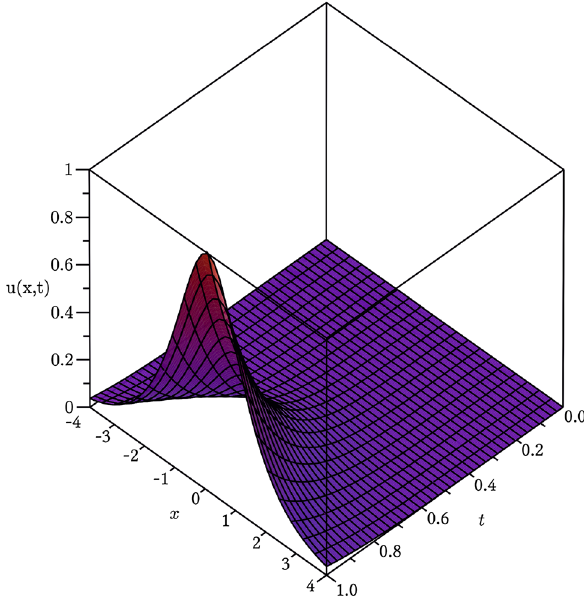
Fig. 1 Plot of approximate solution of Example 1 for α = 0 . 5, τ = 0 . 005 and [ a , b ] = [− 4 , 4 ] obtained by IQ-RBFs